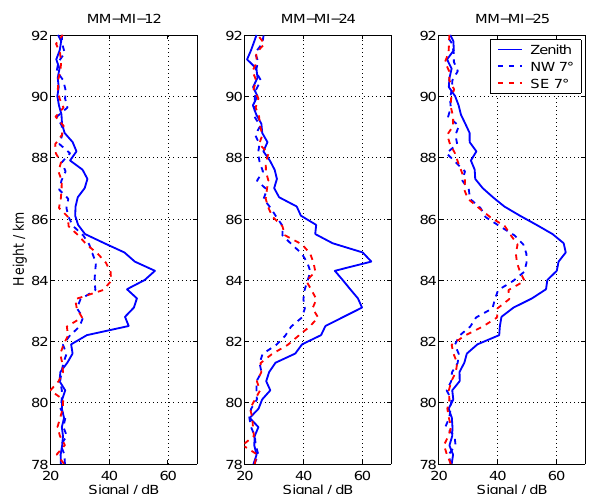
Fig. 3. Signal power profiles of the three rocket flights for the ver- tical and both off-zenith pointing beams as 20min medians near the apogee time of the 3 sounding rockets launched during the MI- DAS/MaCWAVE campaign. The solid lines show the signal re- ceived from the vertical beam and the dashed lines the signal from the 7 ◦ NW and SE beams.